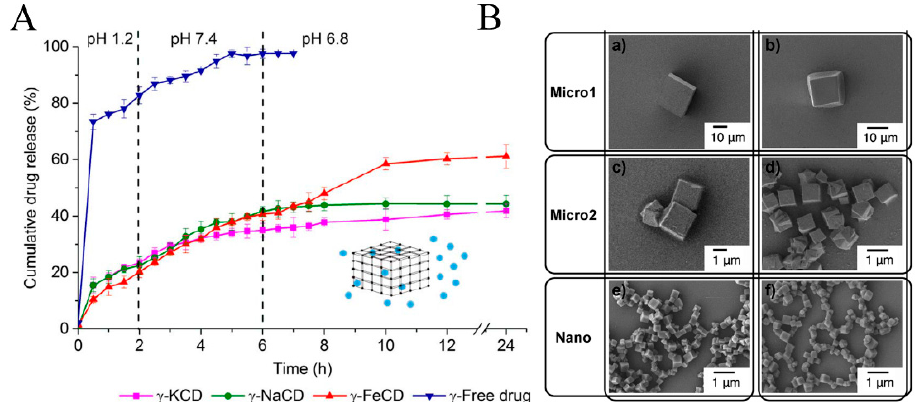
Figure 3. The drug release curve of three CD-MOFs in different pH solutions ( A ) and morphologies of CD-MOFs in different sizes ( B ). Reprinted with permission from [58,66], copyright Elsevier, 2018 and Wiley, 2012.